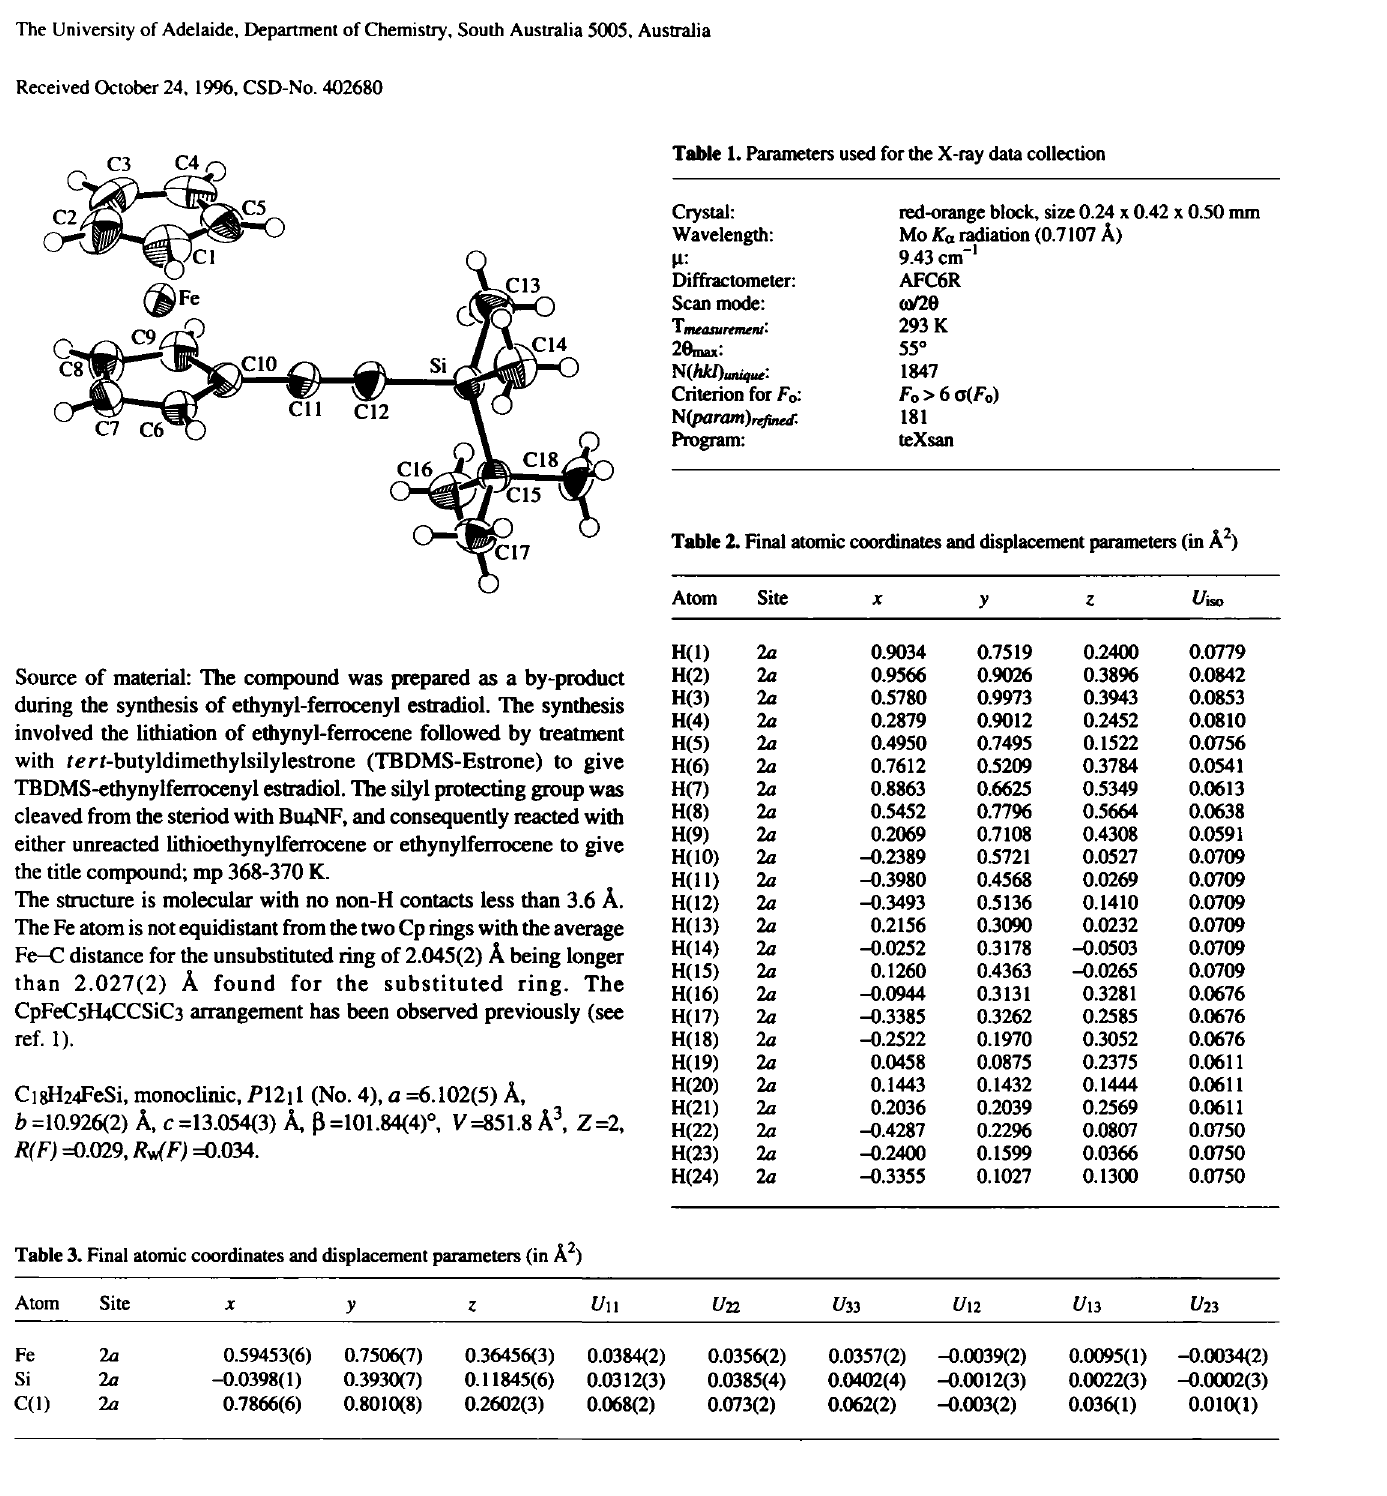
Table 1. Parameters used for the X-ray data collection